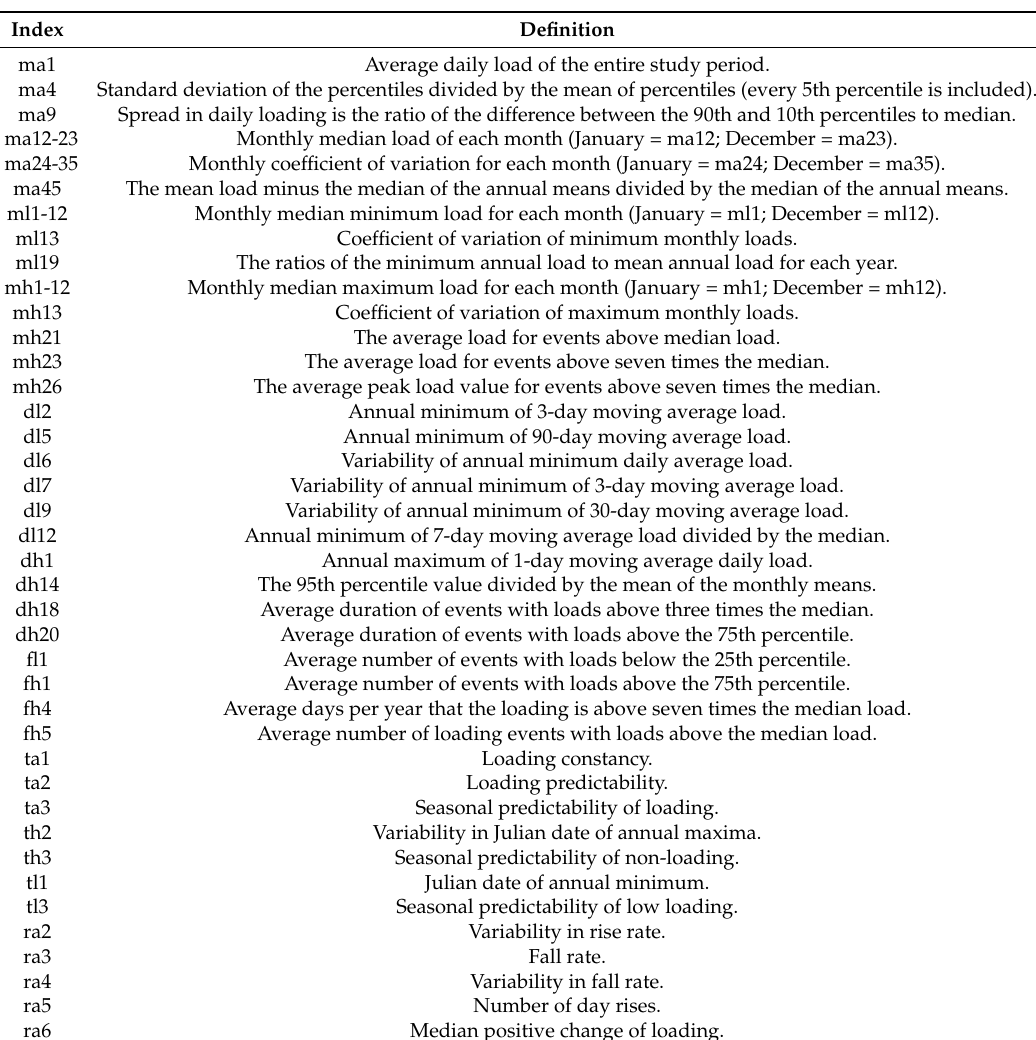
Table 5. Definitions for select indices to quantitatively define major elements of the loading regime in Hinkson Creek, Missouri, USA. Definitions were revised from Kennen et al., 2009